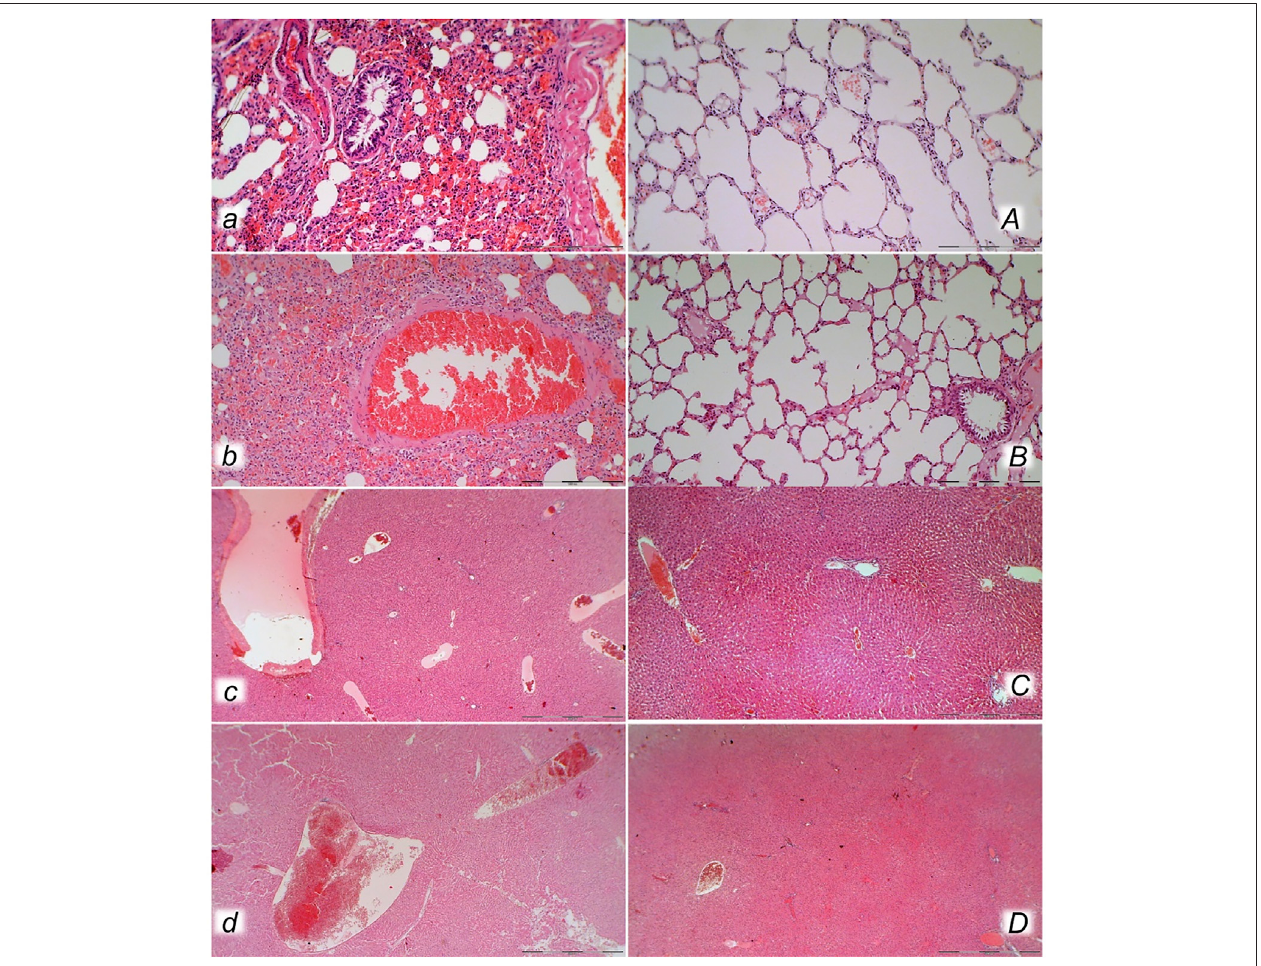
FIGURE 10 | Lung ( a, A, b, B ) and liver ( c, C, d, D ) presentation in rats with the increased intra-abdominal pressure at 25 mmHg for 60 min ( a, A, c, C ) or at 50 mmHgfor25 min( b,B,d,D ),treatedat10 minincreasedintra-abdominalpressuretimewithsaline(control, a,b,c,d )orBPC157( A,B,C,D ). a,b. Lungparenchyma with marked congestion and large areas of intra-alveolar hemorrhage in control rats. A, B. Normal lung parenchyma in BPC 157-treated rats. c, d . Vascular dilatation of liver parenchyma in controls, normal architecture in BPC 157 treated rats (C) and slight congestion of liver parenchyma ( D ). (HE; magni fi cation × 200, scale